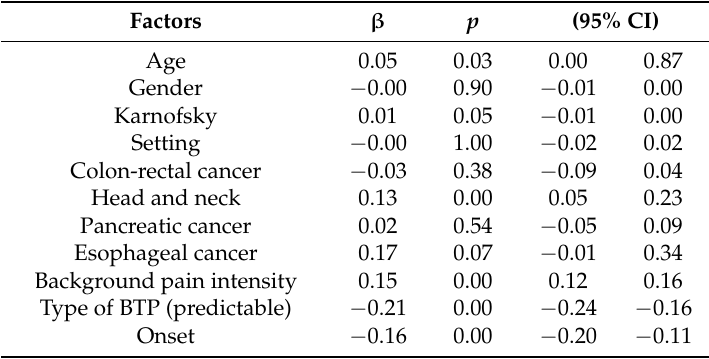
Table 2. Multivariate analysis for the number of BTP